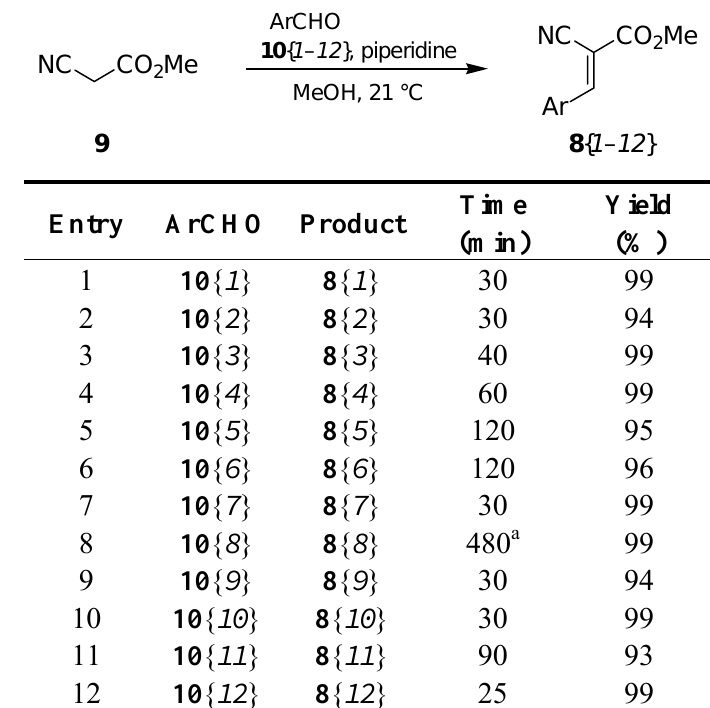
Table 1. Knoevenagel condensation reaction to form the 2-cyanoacrylates 8 { 1 – 12